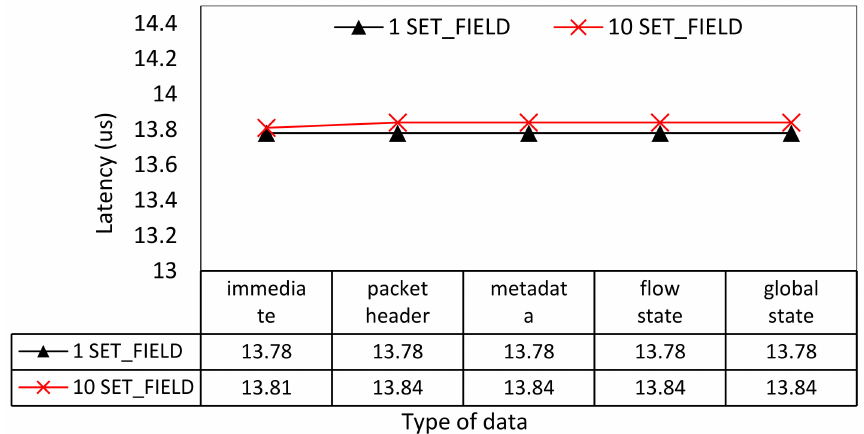
Figure 9. The impact of different types of data processing on packet forwarding